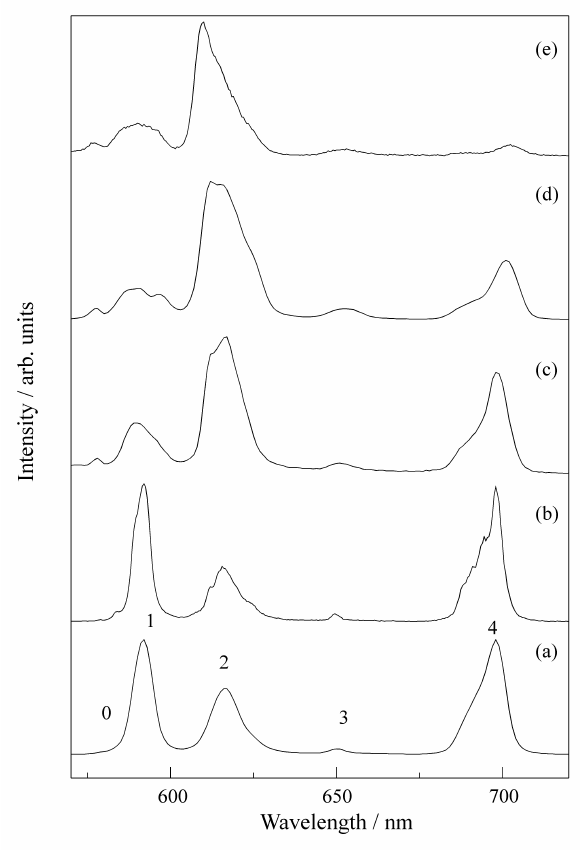
Figure 2. Eu 3+ 5 D 0 emission spectra in SiO 2 system under 5 L 6 excitation (395 nm). (a) Sol ( t ( 5 D 0 ) = 0.14 ms); (b) Wet gel ( t ( 5 D 0 ) = 0.26 ms); (c) Dried gel 120 °C ( t ( 5 D 0 ) = 0.70 ms); (d) Dried gel 500 °C ( t ( 5 D 0 ) = 1.35 ms) and (e) Dried film 500 °C ( t ( 5 D 0 ) = 1.35 ms). The labels refer to